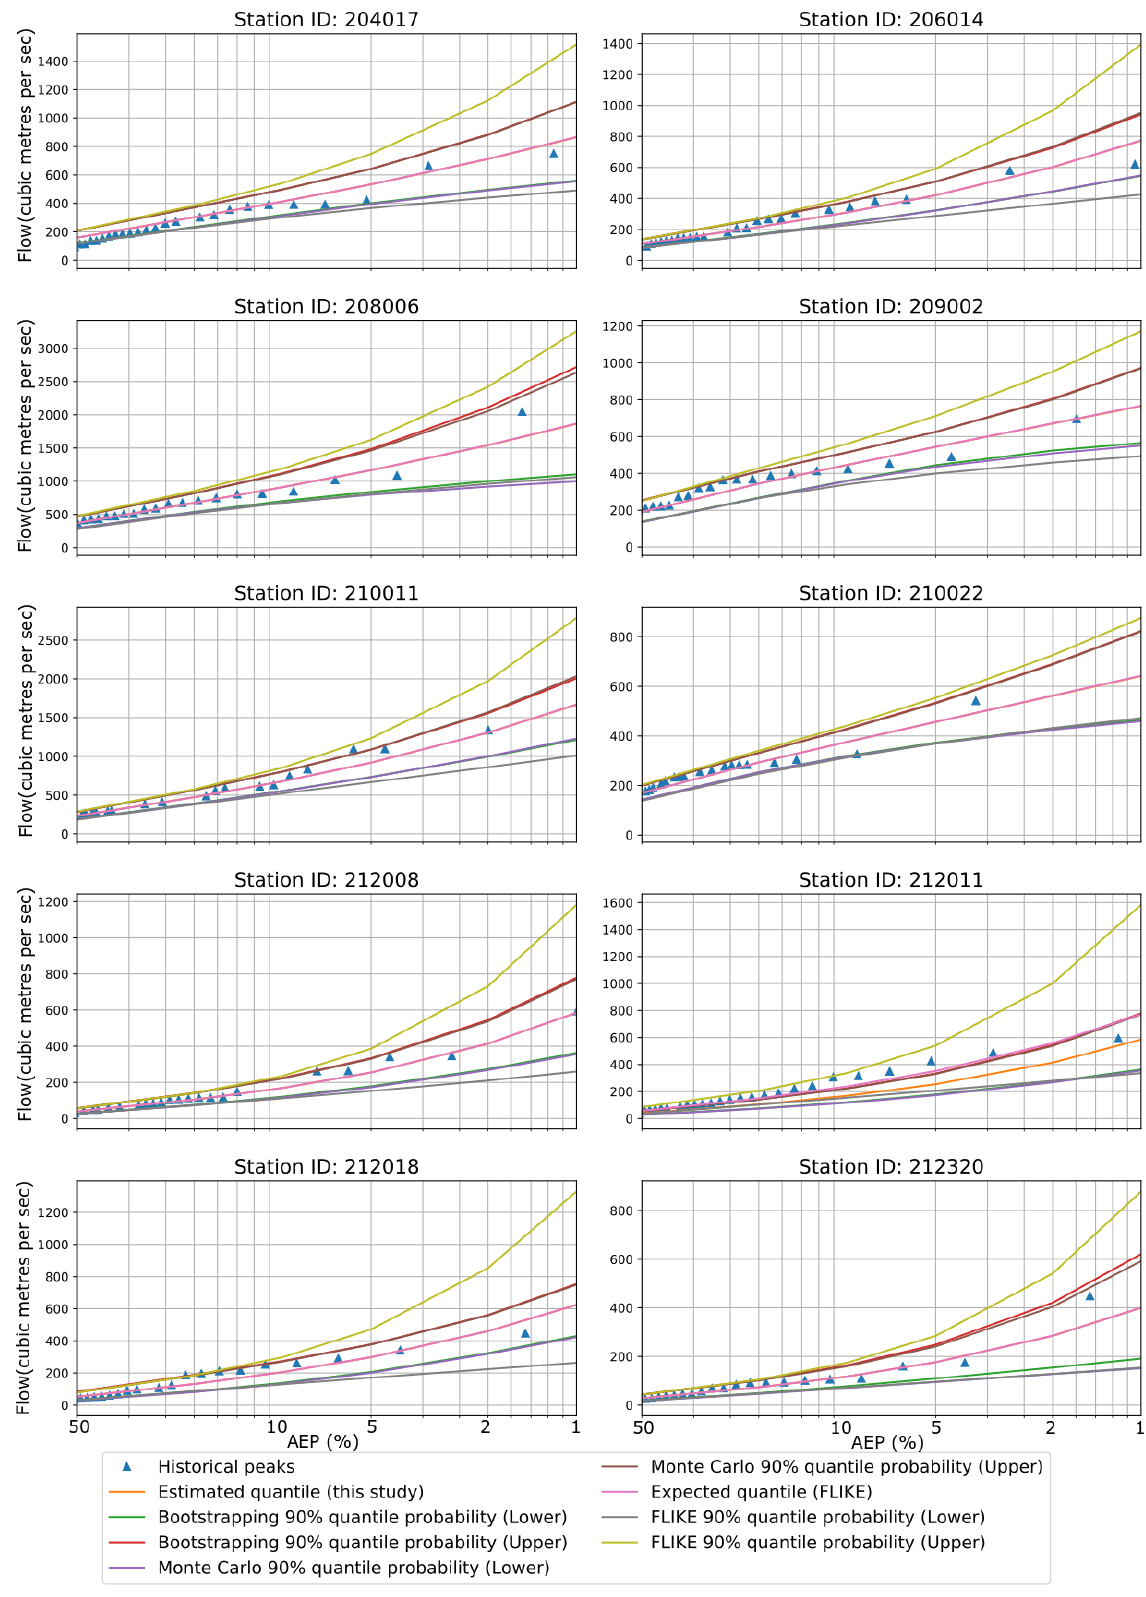
Figure 4. Flood quantiles from FLIKE and GEV distribution are presented over various AEPs for all 10 stations. CIs are estimated by FLIKE, BS, and MCST. The blue triangle symbolizes historical peak.